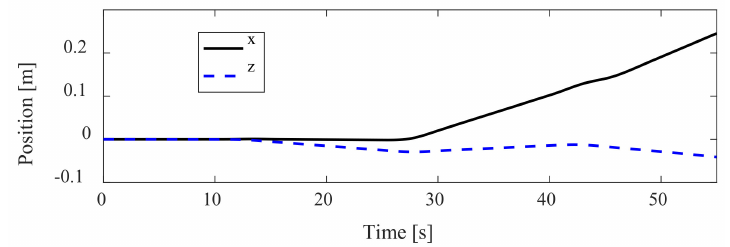
Figure 8. The position of the vehicle without control.